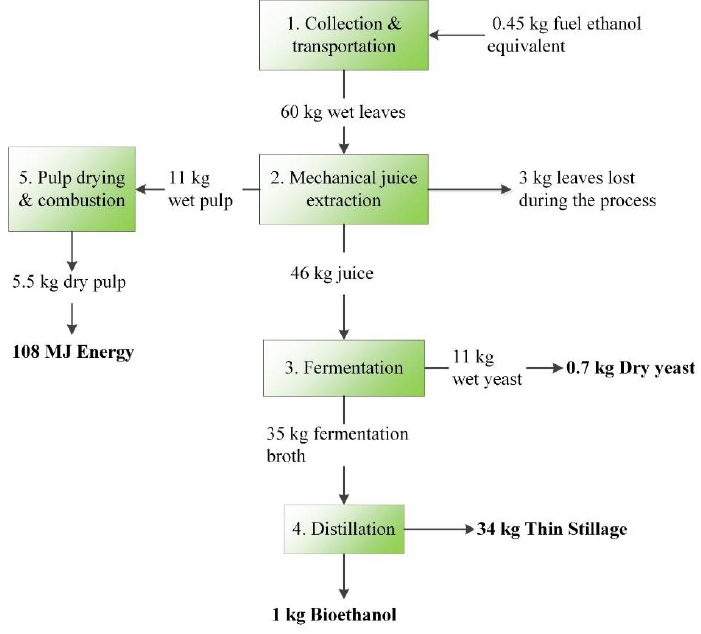
Figure 2. Mass balance of 1 kg ethanol production from pineapple leaves. Table 2. Energy balance of a regional pineapple leaf biorefinery a, b